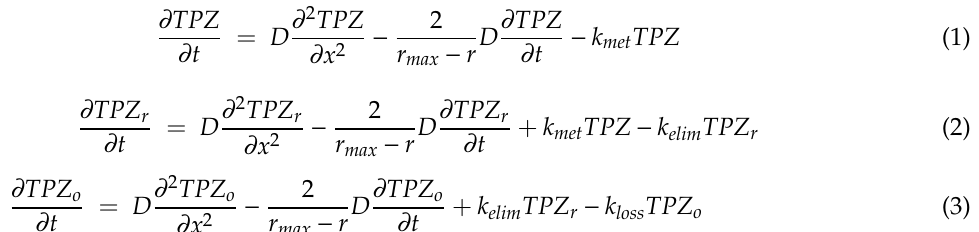
Table 1. Rate constants for TPZ metabolism in POR-expressing MDA-231 cells under anoxia.